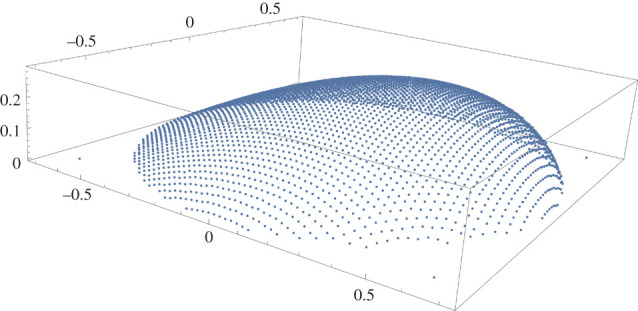
dx × dy mesh for sample α = 30° and θ0 = 45°, with Bo = 1.015. Mesh size: 0.01 × 0.01.